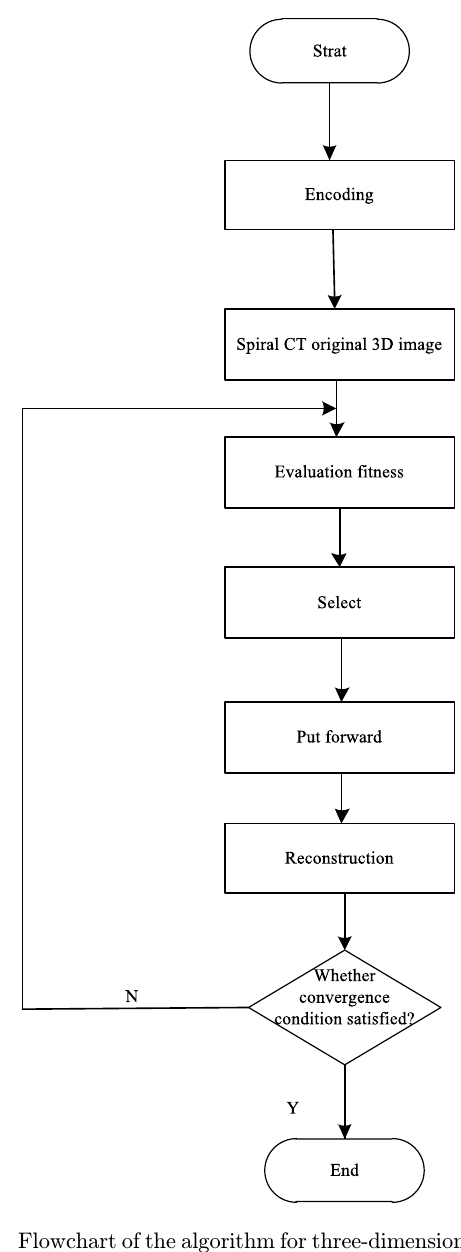
Fig. 3. Flowchart of the algorithm for three-dimensional spiral CT damage image.